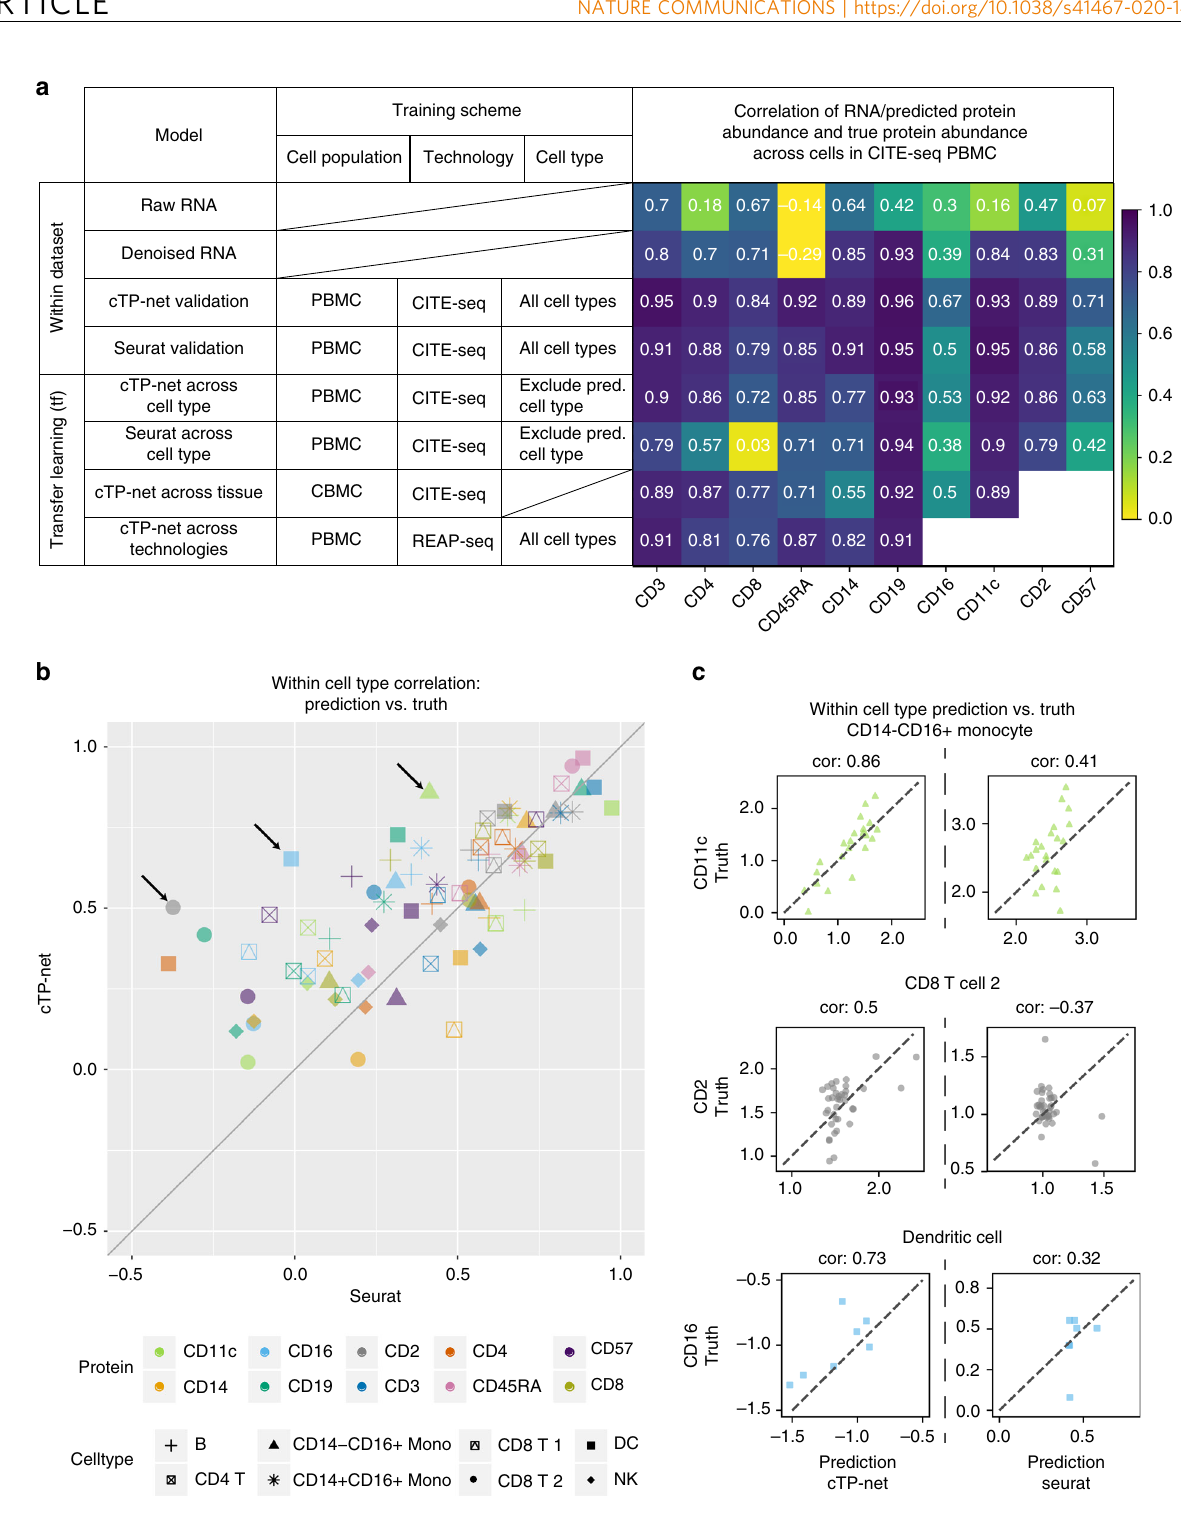
Fig. 2 Benchmark evaluation on CITE-seq PBMC data. a Benchmark evaluation of cTP-net on CITE-seq PBMC data, with comparisons to Seurat v3, in validation, across cell type, across tissue, and across technology scenarios. The table on the left shows the training scheme of each test, the heatmap shows correlations with actual measured protein abundances. b Within cell type correlations between imputed and measured protein abundance on the CITE-seq PBMC data, Seurat v3 versus cTP-net. Each point (color and shape pair) indicates a cell type and surface protein pair, where the x -axis is correlation between actual measured abundance and Seurat imputation and y -axis is the correlation between actual measured abundance and cTP-net imputation. c Scatter of imputed versus measured abundance for the three (surface protein, cell type) pairs marked by arrows in b : CD11c in CD14 − CD16 + monocytes, CD2 in CD8 T cells, and CD19 in dendritic